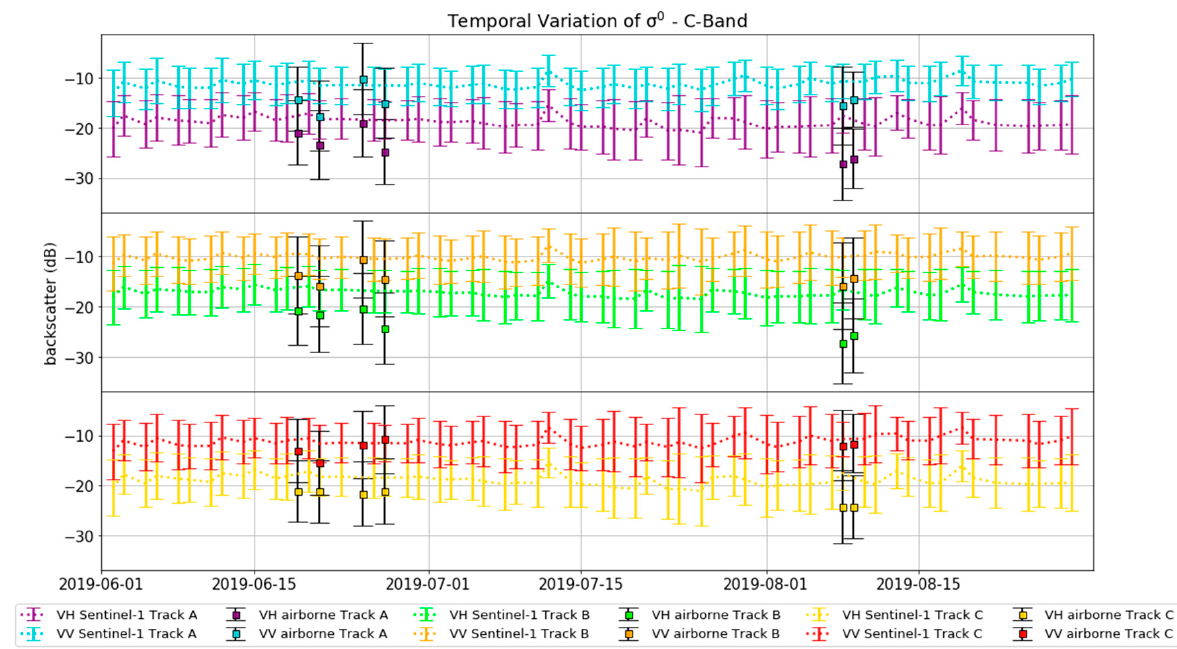
Figure 8. Temporal behavior of backscattering signals of C-band air- and space-borne data for the flight tracks A, B, and C. Concerning the C-band, the mean values of the flight tracks are in general lower than the mean values derived from Sentinel-1. Track A is about − 3.23 dB in VV polarization and − 5.55 dB in VH polarization, track B − 3.88 dB and − 6.69 dB, and track C − 2.21 dB and − 4.24 dB below the satellite data. Comparing the months June and August, smaller deviations can generally be observed in June, with a mean difference of − 2.91 dB and − 3.38 dB in VV polarization for the tracks A and B and − 10.66 dB, − 11.50 dB, and − 9.90 dB in VH polarization for the tracks A, B, and C, respectively. Only the VV polarization signal of track C, the mean deviation is smallest in August, with − 1.1 dB. In August, the larger deviation between airborne and satellite data can be observed for track A and B, with − 4.19 dB and − 4.94 dB in VV and − 16.00 dB and − 16.37 dB in VH polarization, respectively, as well as in track C with − 13.59 dB in VH polarization. Here, only C band VV polarization has higher deviations in June with − 1.43 dB. Looking more closely at the temporal behavior of the mean backscattering signals, the variability within the airborne data is higher than within the satellite data. In the period of the airborne SAR recordings in June and August, the mean VV polarized backscattering signals of the airborne tracks have a range of 7.36 dB (track A), 5.31 dB (track B) and 4.70 dB (track C), whereas the mean